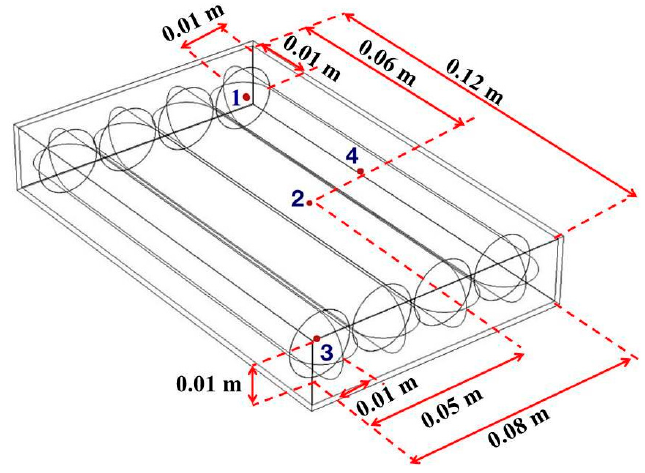
Figure 4. Four measurement points (points 1–4) for sausages in package.